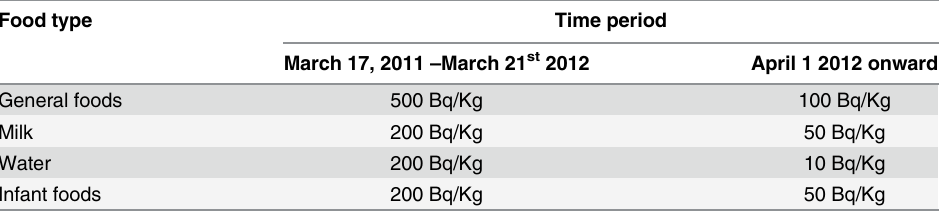
Table 1. Residue limits in Japanese food after the Fukushima dai ichi nuclear accident, by time period. Food